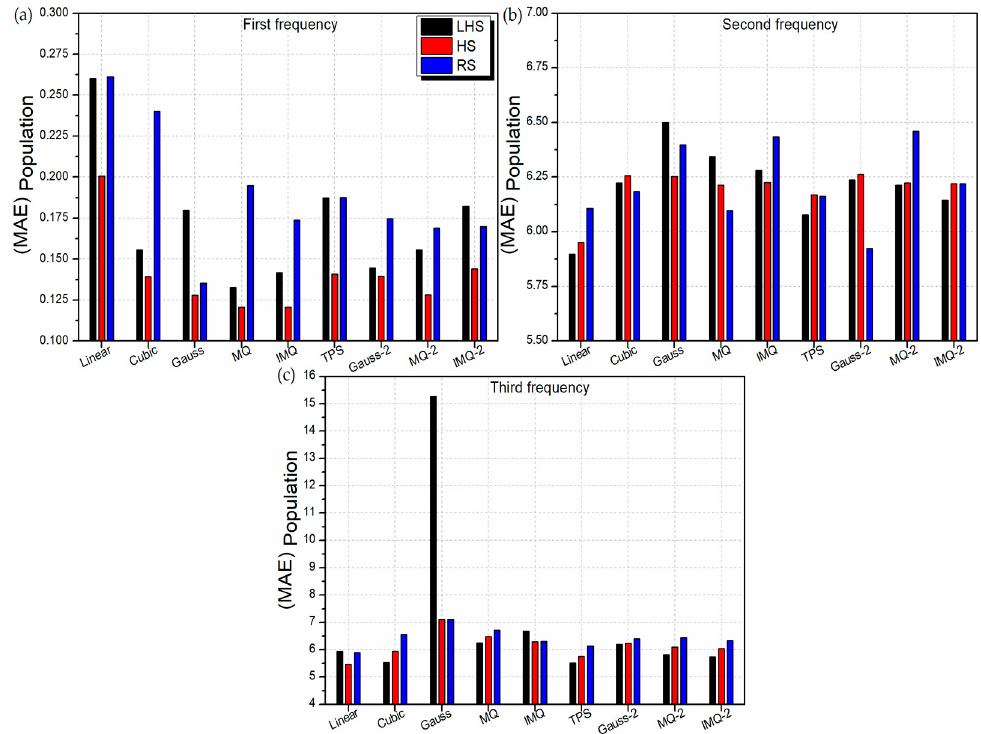
Figure 7. MAE values of various RBF metamodels in LD problem considering entire population.